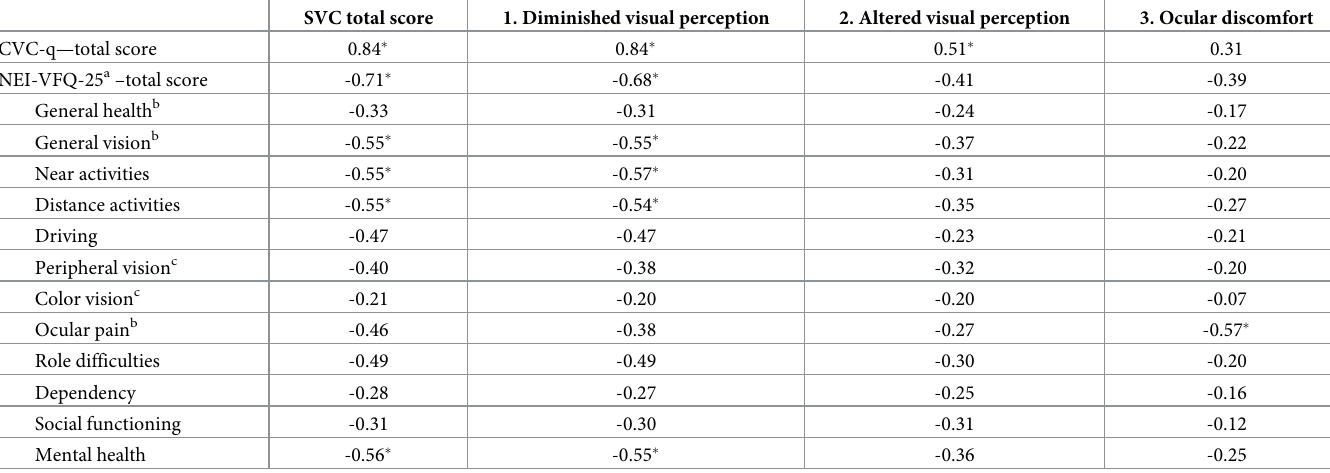
Table 4. Convergent validity of the SVC with the CVC-q and the NEI-VFQ-25. SVC total